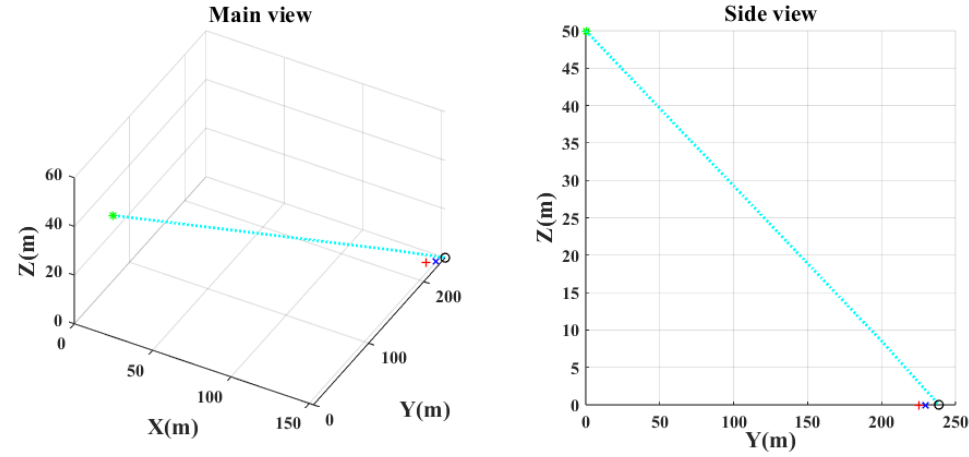
Figure 17. The ballistic of SID-IRL in case 2.